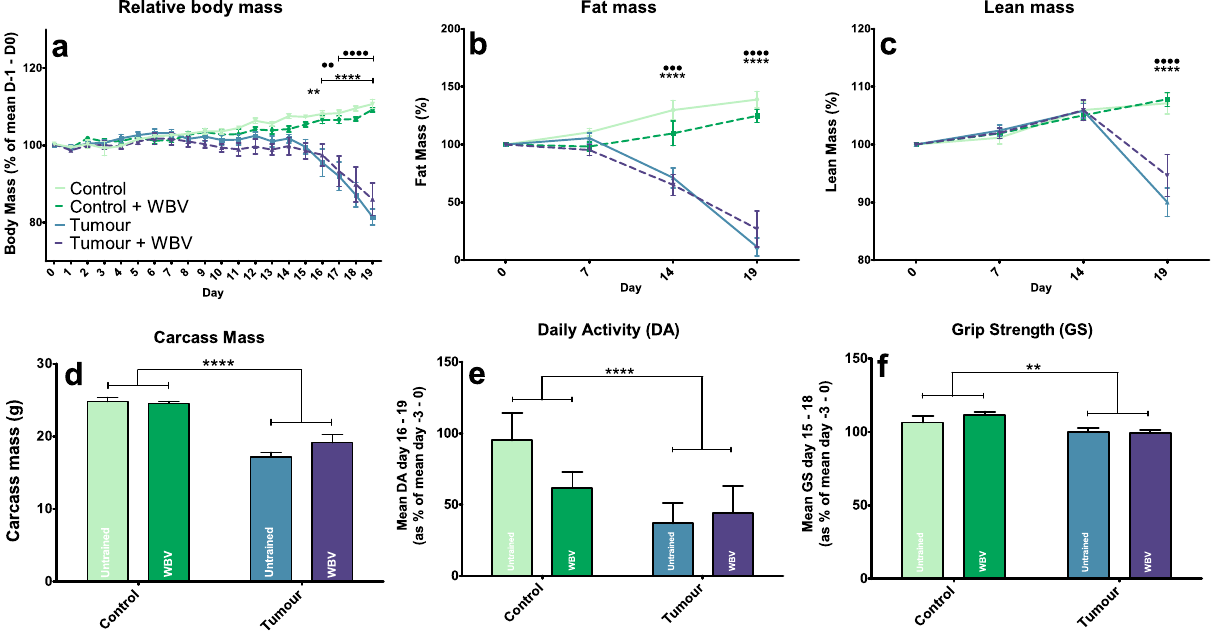
Figure 1. Relative body mass ( a ), fat mass ( b ) and lean mass( c ) over time, carcass mass at section ( d ), mean daily activity ( e ) and grip strength ( f ) at the end of the experiment. Data represent mean ± SEM. Asterisks indicate significant differences between C and T and dots indicate significant differences between C + WBV and T + WBV. */ •, **/ ••, ***/ ••• and ****/ •••• indicate p < 0.05 , p < 0.01 , p < 0.005 and p < 0.001 respectively.